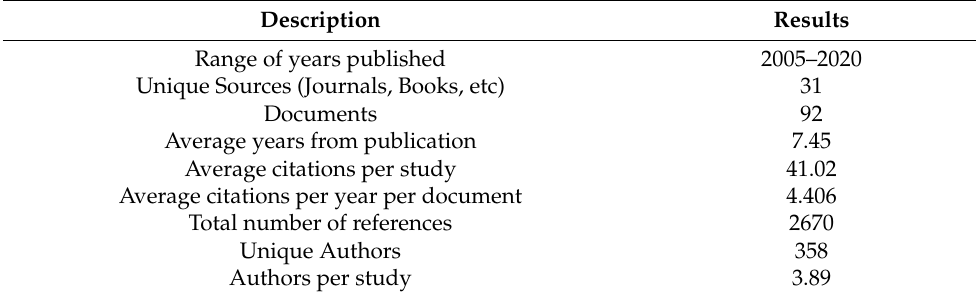
Table 1. Summary of corpus of extracted